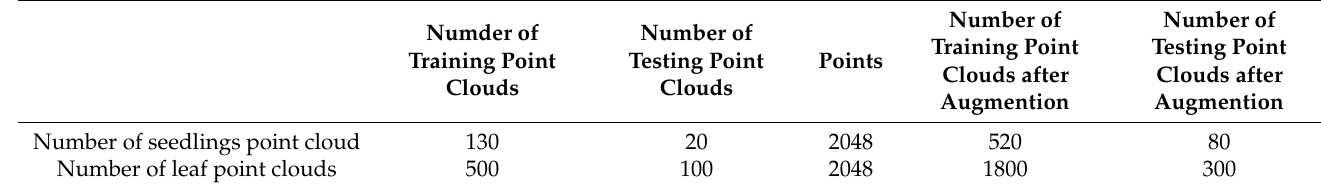
Table 1. Training datasets and testing datasets